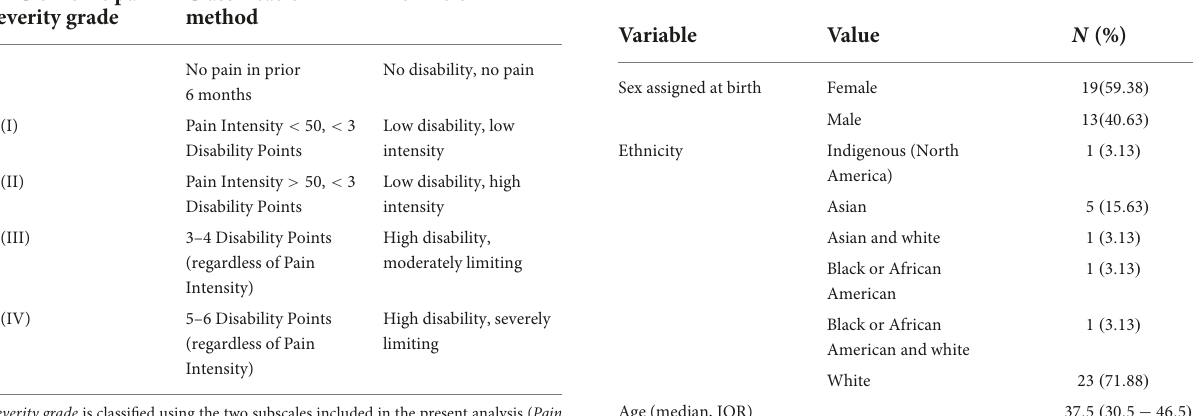
receiving MDMA-assisted therapy for PTSD included in this analysis ( n =